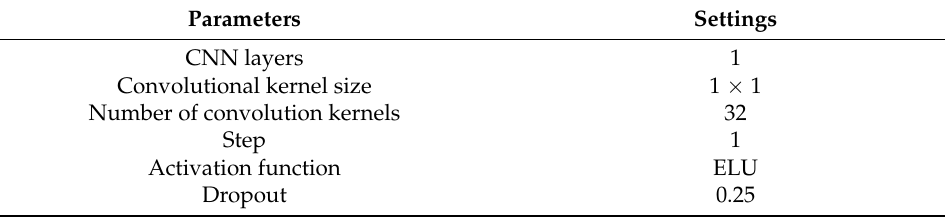
Table 2. CNN parameters.